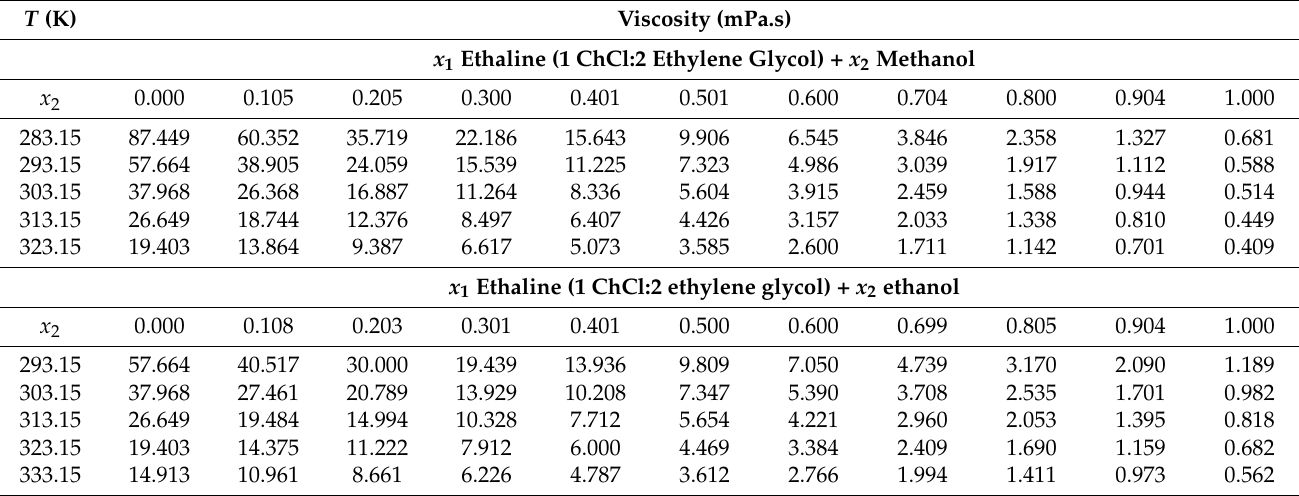
Table 3. Experimental viscosities of Ethaline + methanol/ethanol at the investigated temperatures and at a pressure of 100 kPa a,b,c .